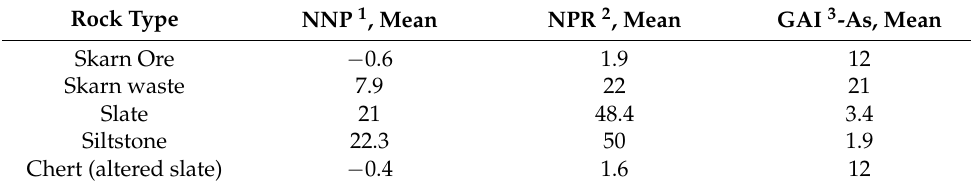
Table 1. Summary of ARDML indicators for the main waste rock types.